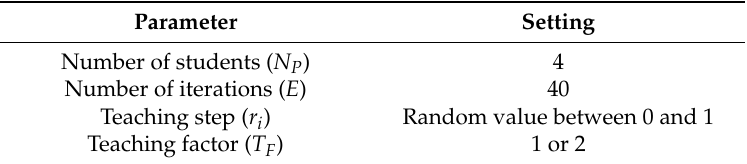
Table 3. Conventional TLBO parameter settings.